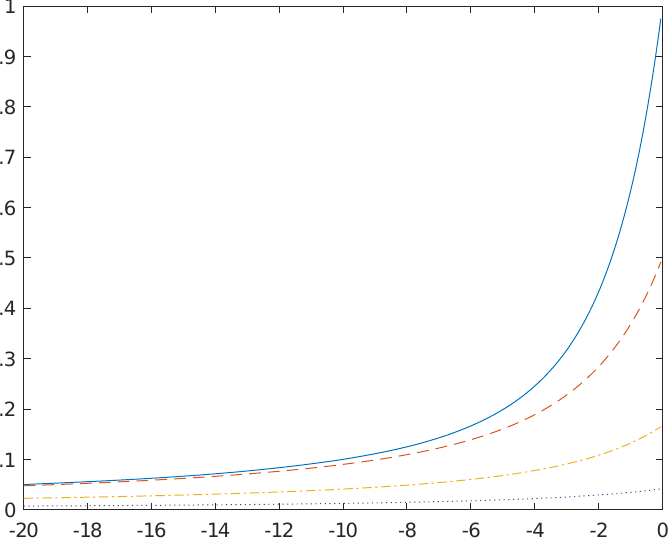
Figure 2. ϕ 1 (continuous line), ϕ 2 (dashed line), ϕ 3 (dash-dotted line), ϕ 4 (dotted